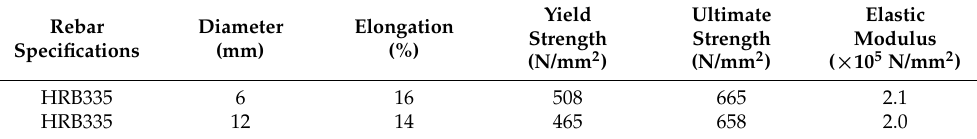
Table 4. Mechanical properties of the reinforcement.